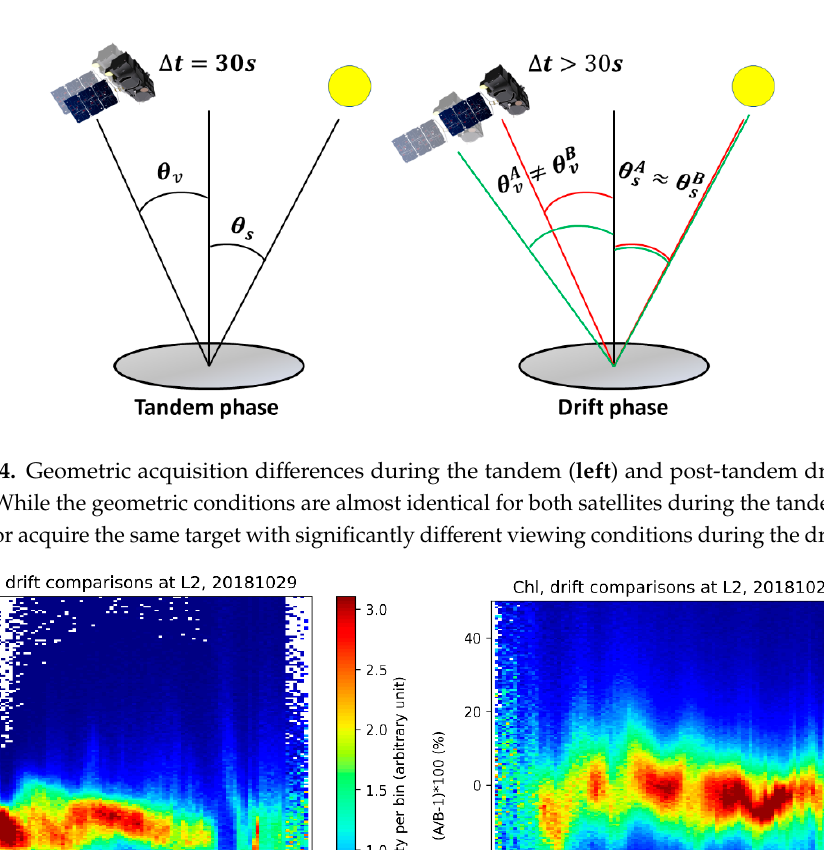
Figure 14. Geometric acquisition differences during the tandem ( left ) and post-tandem drift phase ( right ). While the geometric conditions are almost identical for both satellites during the tandem phase, the sensor acquire the same target with significantly different viewing conditions during the drift phase.